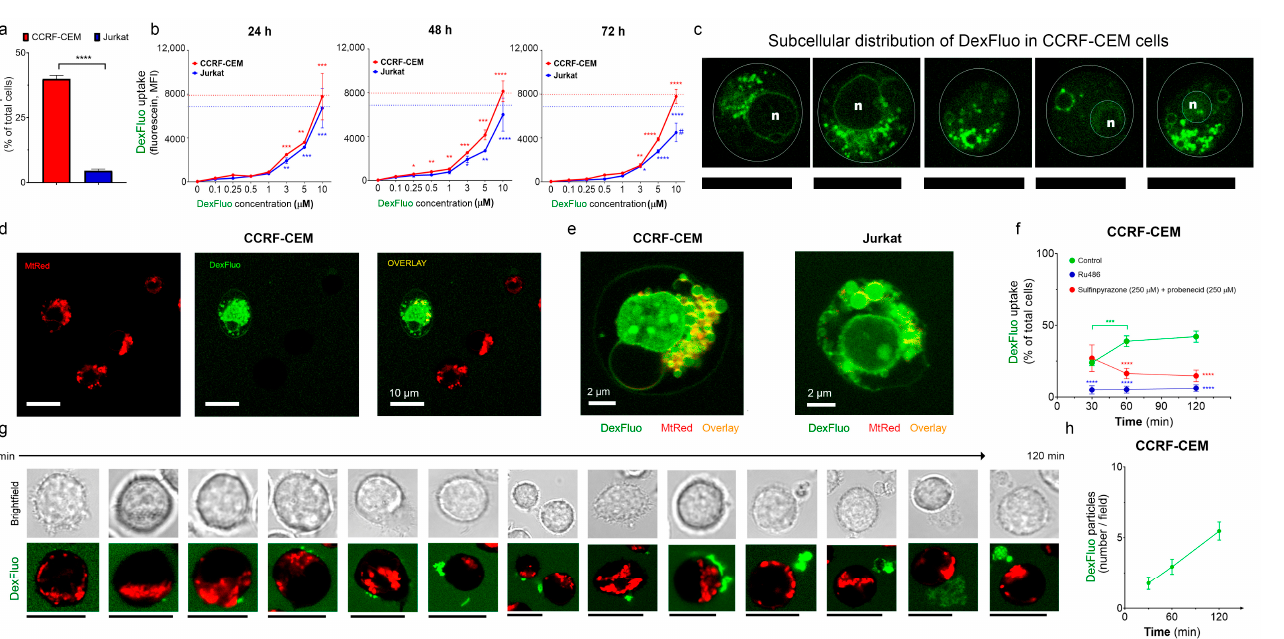
Figure 2. DexFluo uptake and subcellular distribution by T-ALL cells. ( a ) Quantitative analysis of the incorporation of DexFluo (5 µM, 1 h) using confocal microscopy ( n = 4, total of 975 (CCRF-CEM) and 1252 (Jurkat) cells). ( b ) DexFluo accumulation as a function of its concentration in the medium was estimated using flow cytometry at different incubation times (0–72 h). One-way ANOVA with Dunnet’s multiple comparison test was employed. *—comparison vs. control group, #—comparison 72 h vs. 24 h. ( c ) Representative images (40×) of intracellular DexFluo (1 µM; 24 h) distribution in CCRF-CEM cells. Nuclei: n. Scale bar: 10 µm. ( d ) Representative fluorescent micrographs of CCRF- CEM cells exposed to for 2 h to DexFluo (5 µM, green staining) and the mitochondrial probe MtRed (80 nM, red fluorescence). Objective: 40×. Scale bar: 10 µm. ( e ) Representative high magnification (100×) fluorescence overlay images of CCRF-CEM (left) and Jurkat (right) cells after incorporation of DexFluo (5 µM) and MtRed (80 nM) for 2 h. Scale bar: 2 µm. ( f ) Quantitative analysis of DexFluo uptake using CCRF-CEM by confocal microscopy. Green trace: DexFluo (5 µM), n = 4, a total of 1105 cells (30 min: 386; 1 h: 374; 2 h: 345 cells); blue trace: DexFluo (5 µM) in the presence of the GR antagonist Ru486 (5 µM; 20 min pre-incubation), n = 4, a total of 1898 cells (30 min: 634; 1 h: 657; 2 h: 610 cells); red trace: DexFluo (5 µM) after 20 min pre-incubation in the presence of sulfinpyrazone (250 µM) and probenecid (250 µM), n = 4, a total of 1824 cells (30 min: 384; 1 h: 748; 2 h: 692 cells). Two-way ANOVA with Dunnet’s multiple comparison test was employed. Statistical significance against the control group is depicted. ( g ) Examples of the time course of DexFluo (5 µM; 0–120 min) extrusion by CCRF-CEM cells. DexFluo particles are green and mitochondria stained with MtRed (80 nM) are red. Scale bar: 10 µm. ( h ) Quantification of the number of green extracellular particles extruded from DexFluo-treated CCRF-CEM cells over 2 h of observation using confocal microscopy. In ( a – c , f , h ), data are mean ± S.E. for at least 3 independent experiments. ** p <0.01; *** p < 0.001; **** p < 0.0001.